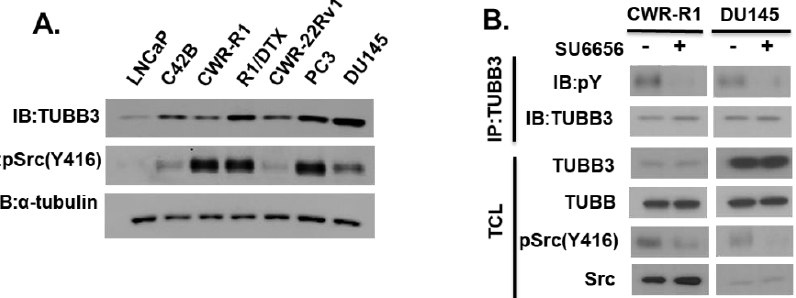
Figure 1. Expression and tyrosine phosphorylation of TUBB3 in prostate cancer cell lines. ( A ) Cell lysates from various PCa cell lines were subjected to immunoblotting using the indicated antibodies. ( B ) PCa cells were treated with either vehicle DMSO or 10 μ M SU6656 (Src-inhibitor) for 2 h. Cell lysates were then subjected to immunoprecipitation (IP) with anti-TUBB3 (TUJ1) antibody, and blotted with indicated antibodies. Total cell lysates (TCL, 10% input) were also collected before IP and subjected to immunoblotting with indicated antibodies.